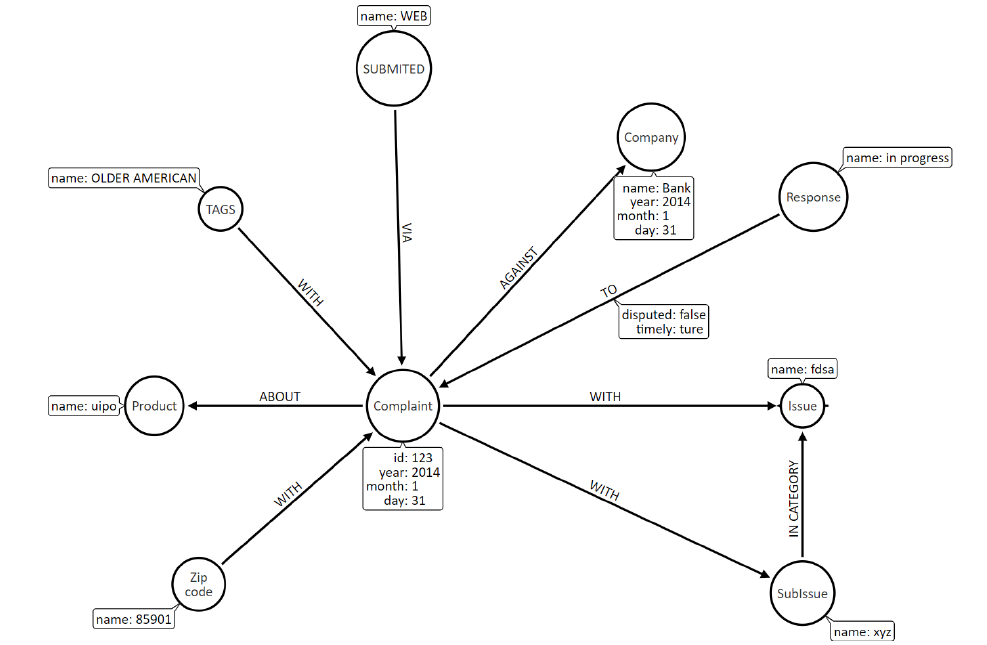
Figure 1. The structure of the processed graph database with labeled vertices (circles and their names), labeled edges (arrows and their names), and properties of